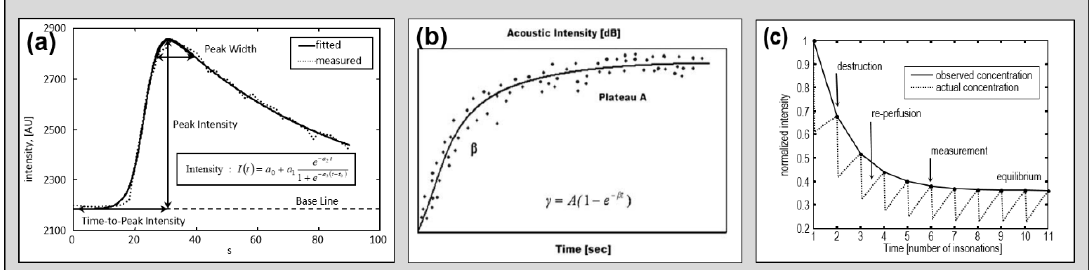
Figure 5. Theoretical course-of-time intensity curves in three di ff erent kinetic models as measured in models. Dotted lines represent measured concentration and straight lines represent course of fitted model function. ( a ) Bolus kinetic [8], ( b ) refill kinetic [18], and ( c ) depletion kinetic [15] with permission of the original